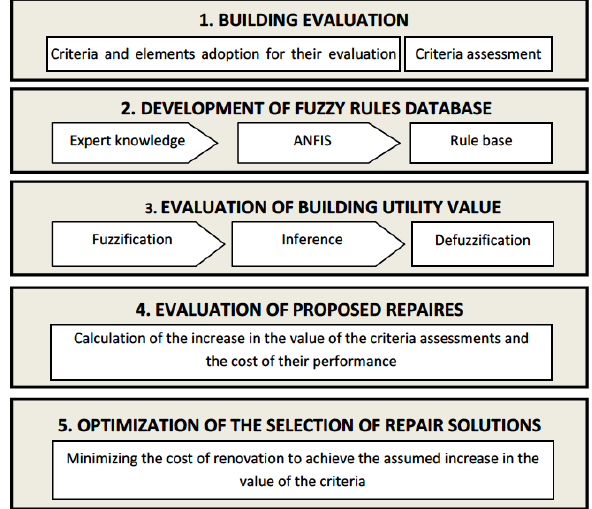
Figure 1: Model supporting renovation and modernization